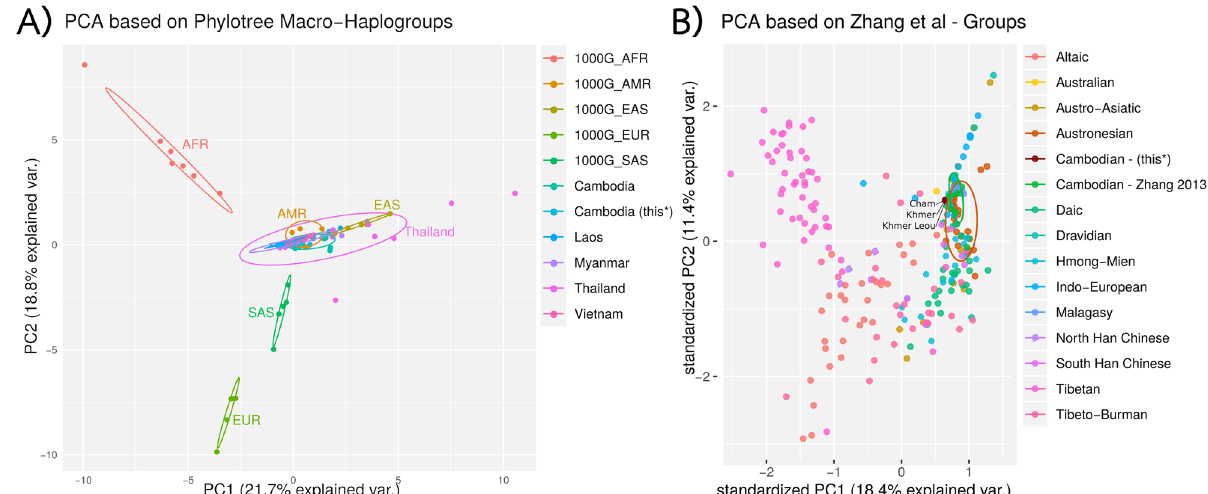
Figure 4. Principle component analysis (PCA) on different haplogroup levels. ( A ) PCA including global populations with the main emphasis put on populations in Southeast Asia on macrohaplogroup level. ( B ) PCA based on data from Zhang et al. 2 with the therein described three ethnic groups (Cambodian (this*)).